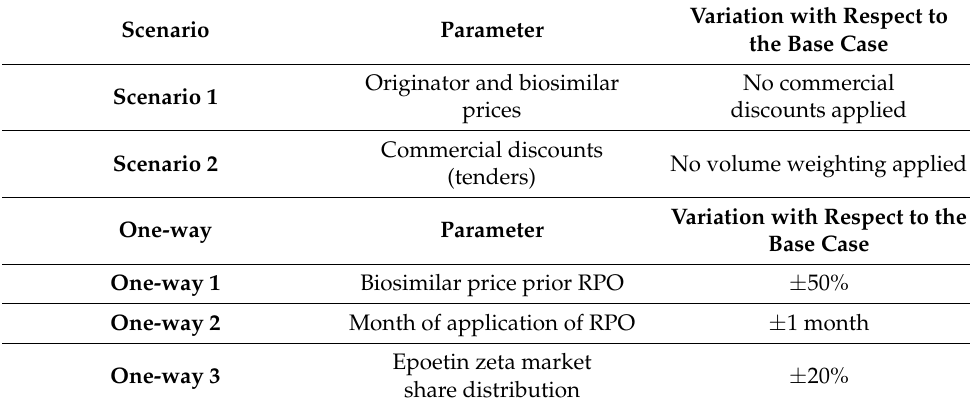
Table 5. Scenario and one-way sensitivity